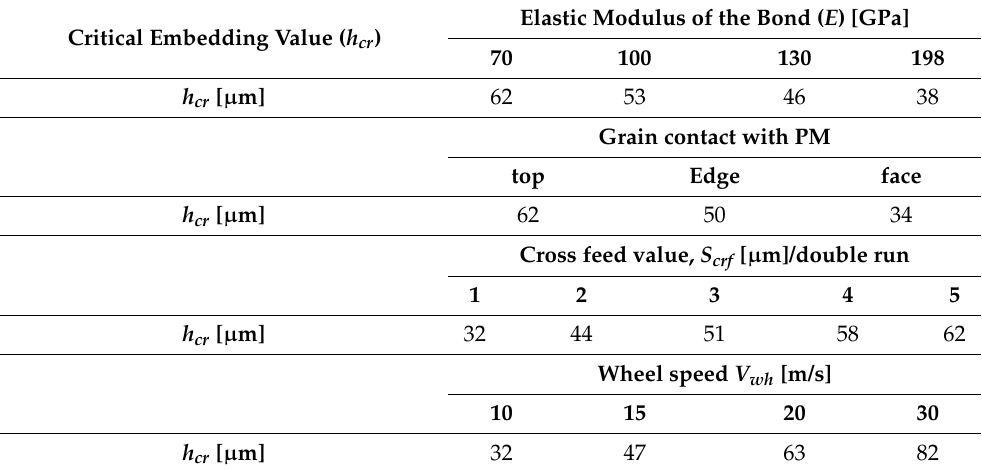
Table 3. Influence of physical and mechanical properties of the bond and loading conditions of the system on the value of the critical embedding of grains in the bond h cr . Critical Embedding Value ( h cr